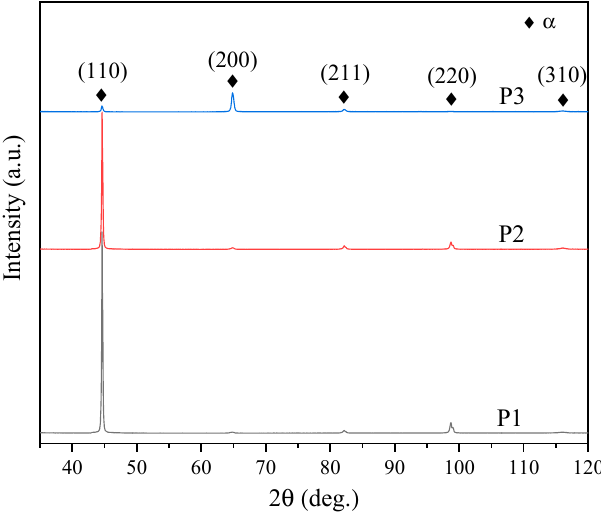
Figure 3. Diffraction patterns of as-built samples under different processes.